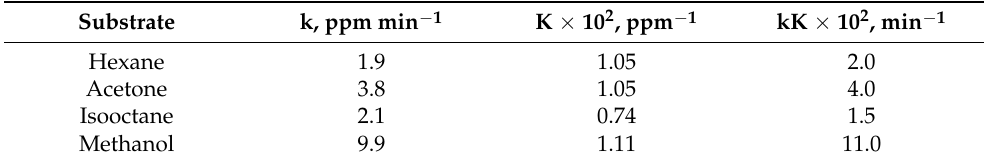
Table 2. Langmuir–Hinshelwood parameters (k and K) relative to the photosensitized oxidation of hexane, acetone, isooctane and